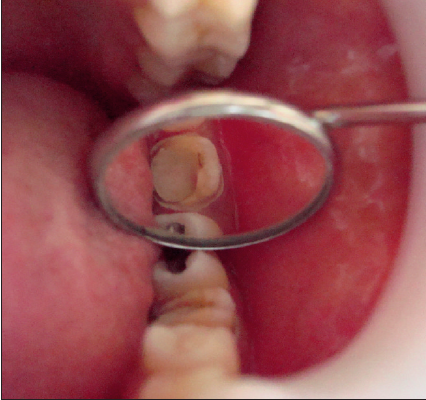
Figure 11: Buccal view of tooth 36 highlighting the excellent shade match and finish.